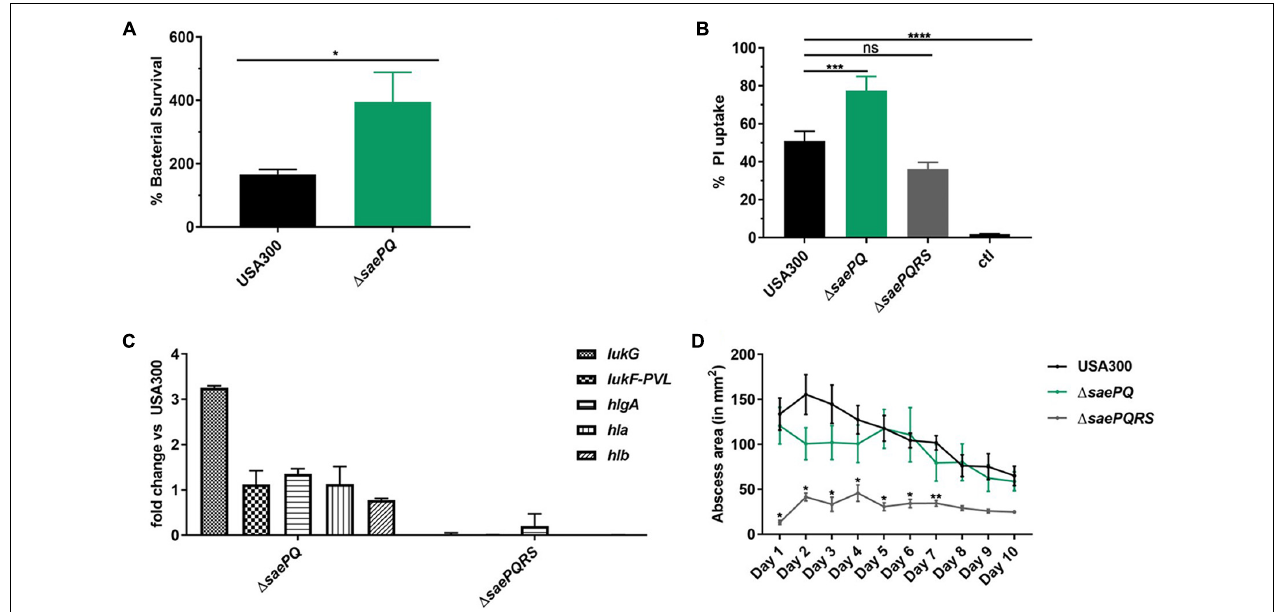
FIGURE 5 | USA300 (cid:49) saePQ demonstrates enhanced survival following neutrophil phagocytosis. (A) USA300 (cid:49) saePQ survives neutrophil killing significantly better than USA300 after 5 h incubation. Data are presented as the mean ± SEM of eight independent experiments. (B) PMN plasma membrane damage was significantly increased in neutrophils infected with USA300 (cid:49) saePQ compared to infection with USA300 (neutrophil: bacteria ratio of 1:5). Propidium iodide uptake was assessed at 3 h post-infection by flow cytometry and indicate USA300 (cid:49) saePQ produces significantly more cytolytic proteins in the supernatants than USA300. Data are presented as the mean ± SEM of five independent experiments. (C) Transcript abundance of lukG is increased in USA300 (cid:49) saePQ relative to expression in USA300 at early stationary phase. Gene transcripts were normalized to gyrB and calibrated to the expression levels of USA300. (D) Deletion of saePQ did not significantly impact abscess area. C57BL/6 mice were infected subcutaneously with 1 × 10 7 CFU of S. aureus . Abscess area was measured daily and results shown are the average of five mice per group. * P ≤ 0.05, ** P ≤ 0.01, *** P ≤ 0.001, **** P ≤ 0.0001 via one-way ANOVA Tukey’s post-test. Data are presented as the mean ±